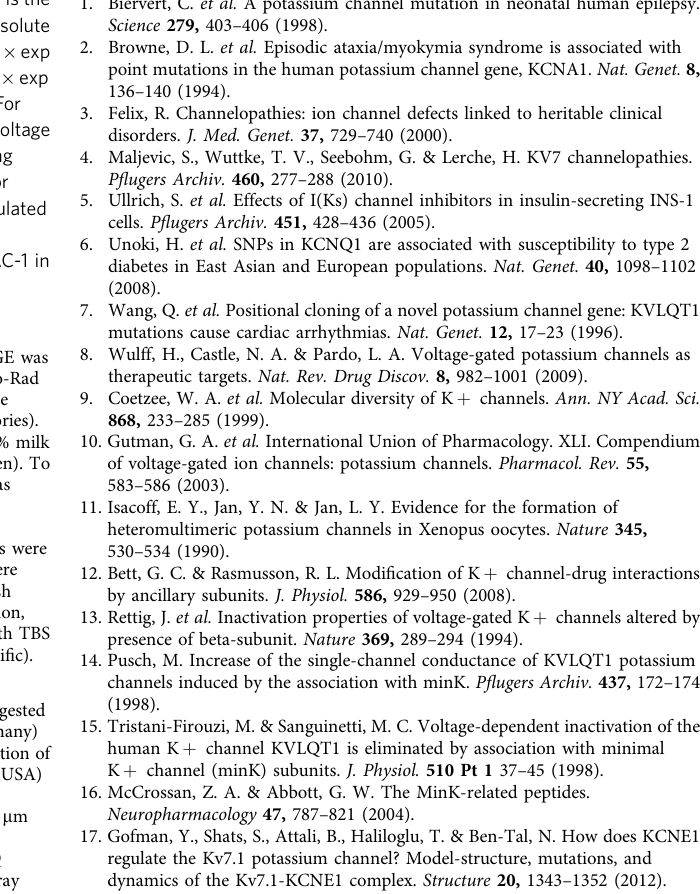
normalized peak inward tail currents at (cid:2) 120mV are plotted as a function of the prepulse potential (5s pulses, control in black and AC-1 in red circles c